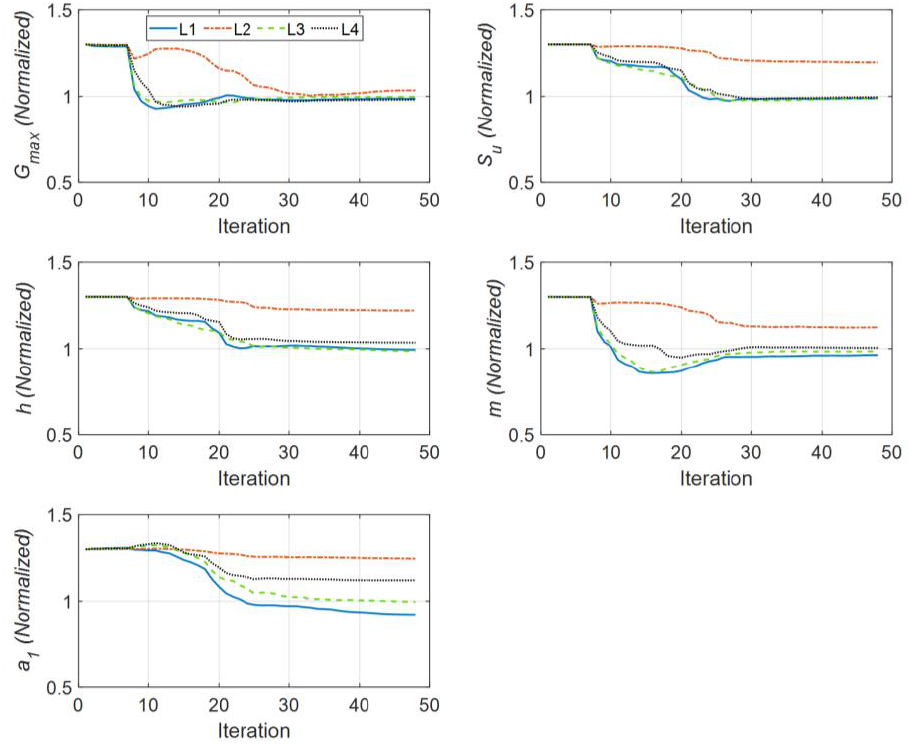
Figure 12. Identified parameters in Case Study 4 (normalized by the corresponding true values).